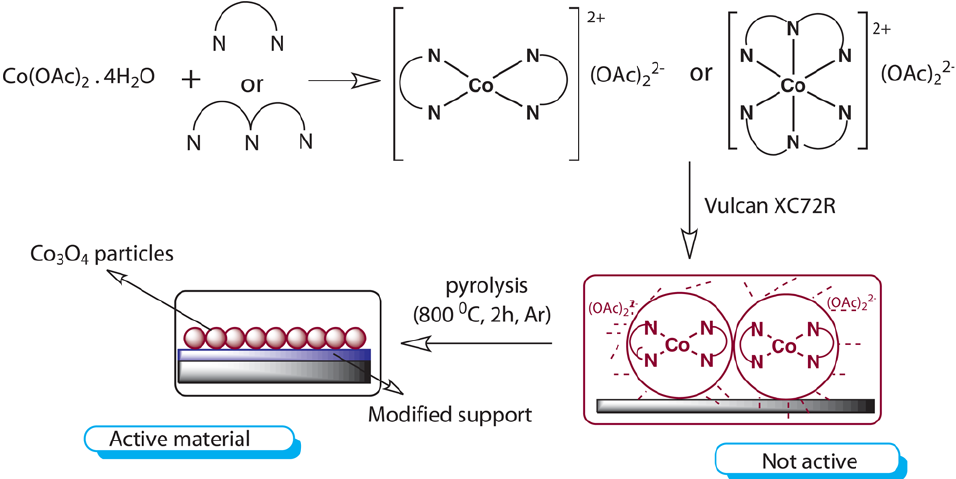
Figure 4. Preparation of Co 3 O 4 -N/C catalysts with different ligands. Reproduced with permission from [22]. Copyright: American Chemical Society 2013. Table 2. Studies of oxidative esterification of furfural to MF over non-noble metal